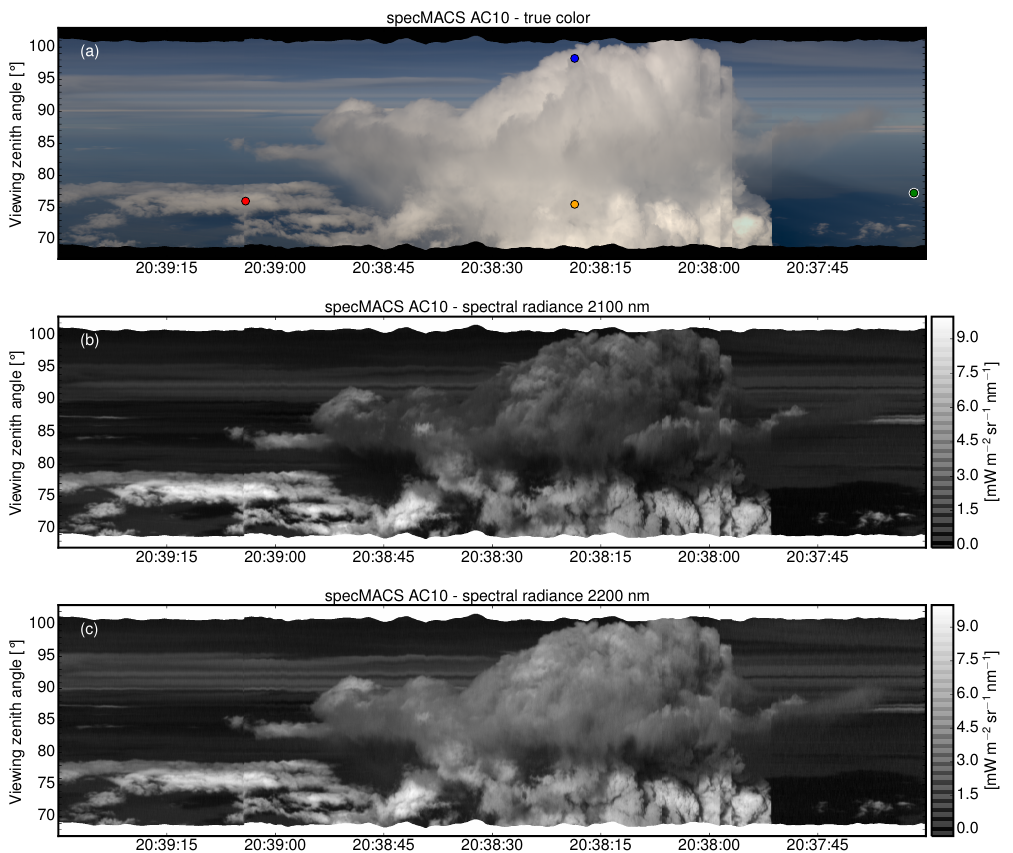
Figure 23. Spectral measurements of cloud sides taken with specMACS onboard HALO during the ACRIDICON-CHUVA campaign in Brazil. (a) True-color RGB calculated from the hyperspectral image, (b) spectral radiance image at 2100nm, (c) spectral radiance image at 2200nm. The ice phase is clearly visible as a distinct drop of the spectral radiances from panel (c) at 2200nm to panel (b) at 2100nm. The drop in radiance can be explained by the stronger ice absorption coefficient at 2100nm compared to